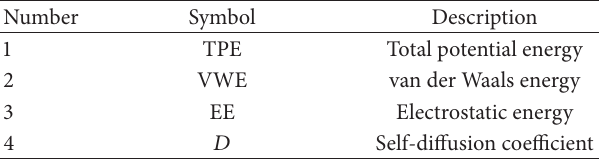
Table 1: List of the simulation